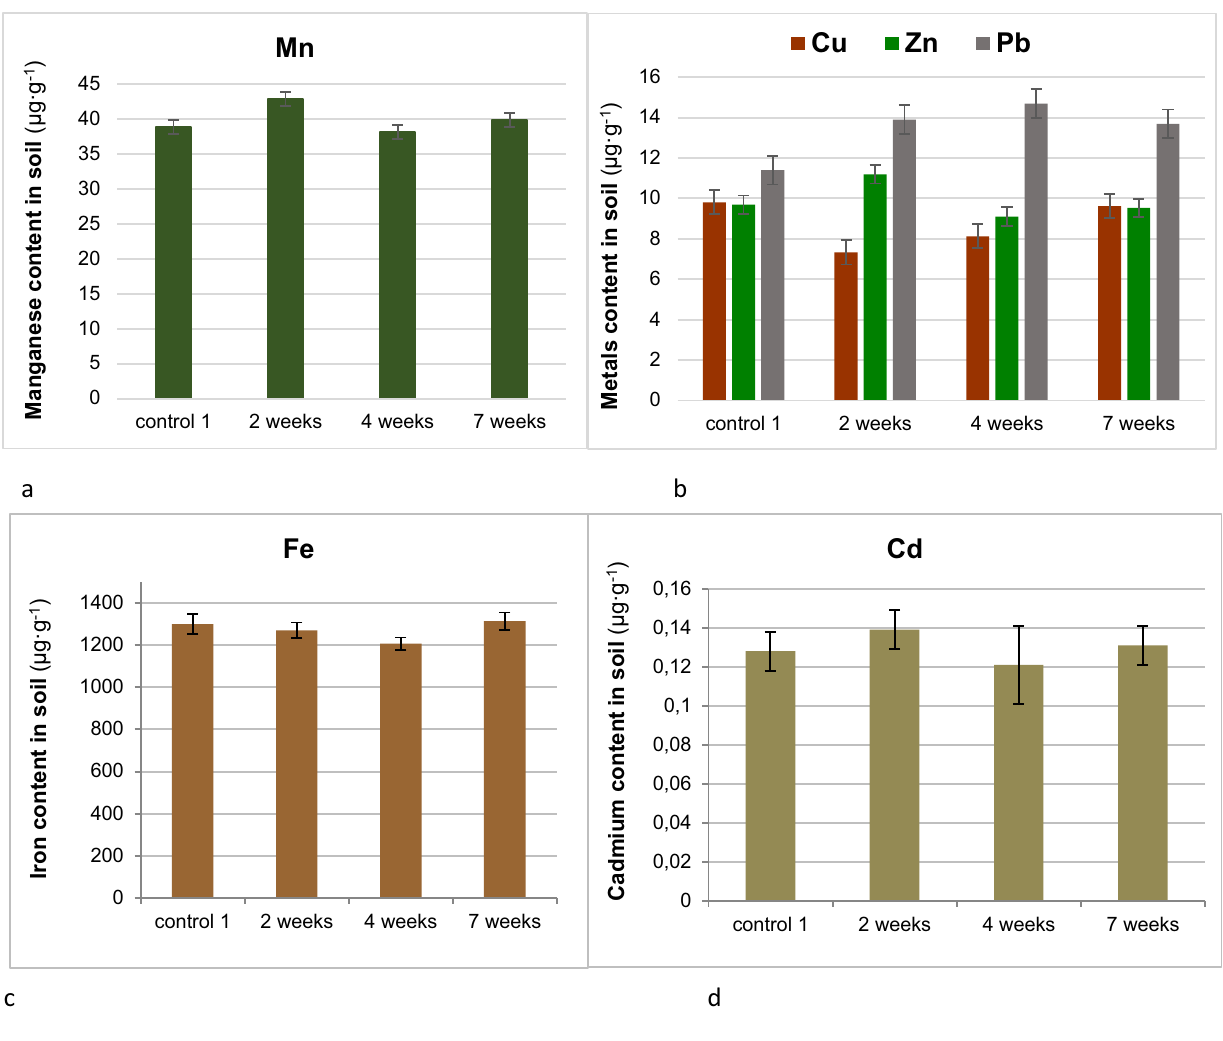
Figure 1. Manganese ( a ), copper, zinc, lead ( b ), iron ( c ) and cadmium ( d ) bioavailable forms in soil supplemented by thiuram displayed against the thiuram contact time (weeks). For clarity, the manganese, iron and cadmium contents are displayed on separate